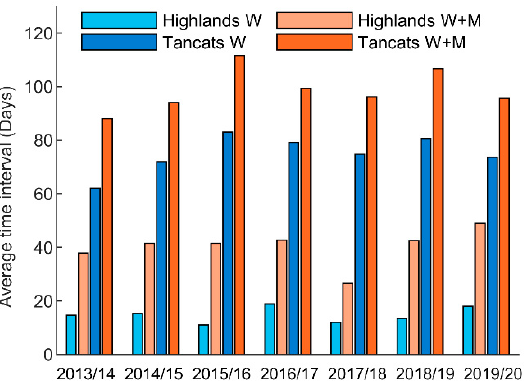
Figure 13. Average number of days of water presence in W and W + M classes, in the Tancats and in the highlands.